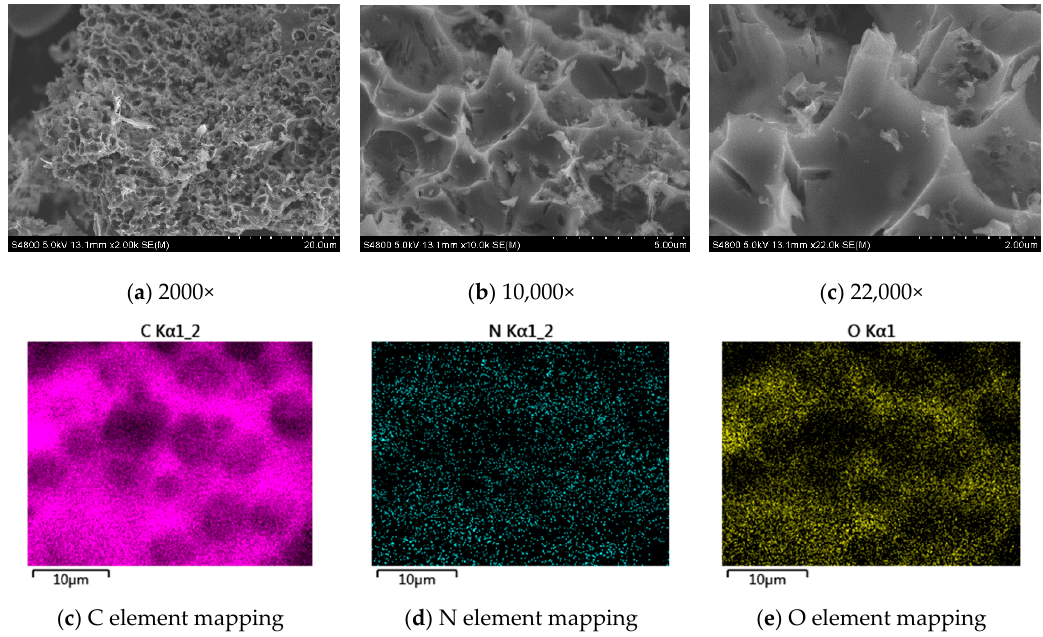
Figure 2. Scanning electron microscopy (SEM) with different magnifications and element mapping images of porous carbon. ( a ) 2000×; ( b ) 10,000×; ( c ) 22,000×; ( d ) C element mapping; ( e ) N element mapping; ( f ) O element mapping.